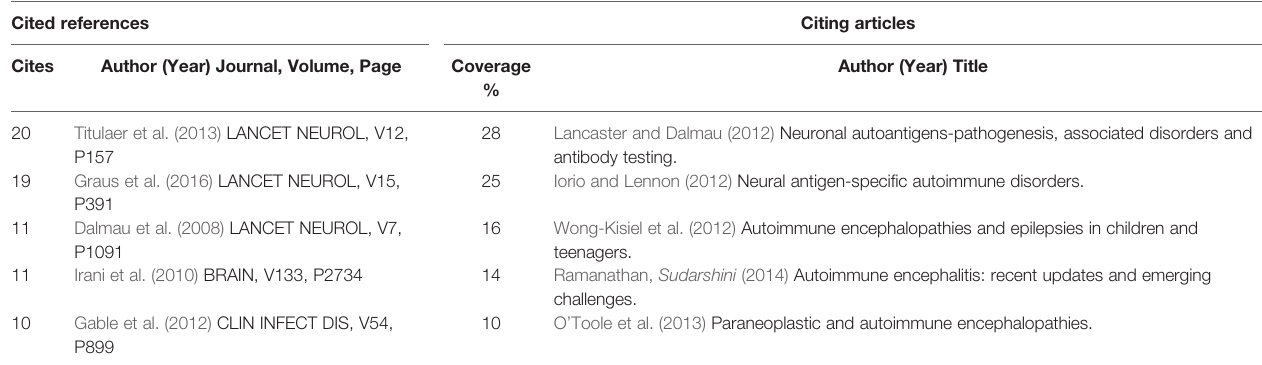
TABLE 4 | Cited references and citing articles of cluster #7 on neuronal autoantigens — pathogenesis.